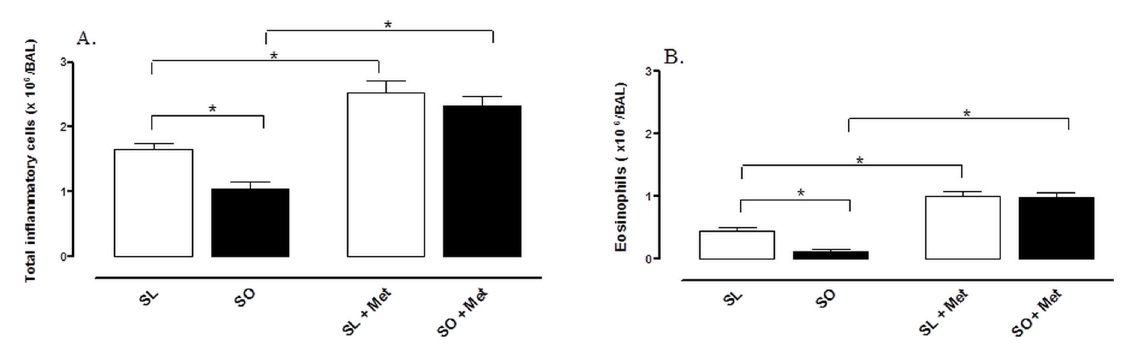
Figure 4. Effect of metformin treatment (300 mg/kg/day, two weeks) on the number of total inflammatory cells (A) and eosinophils (B) in bronchoalveolar lavage (BAL) fluid at 48 h following intranasal challenge with ovalbumin in sensitized mice. Each column represents the mean ± SEM (n = 10) for mice sensitized lean treated with vehicle (SL), sensitized obese treated with vehicle (SO), sensitized lean treated with metformin (SL + Met) and sensitized obese treated with metformin (SO + Met).